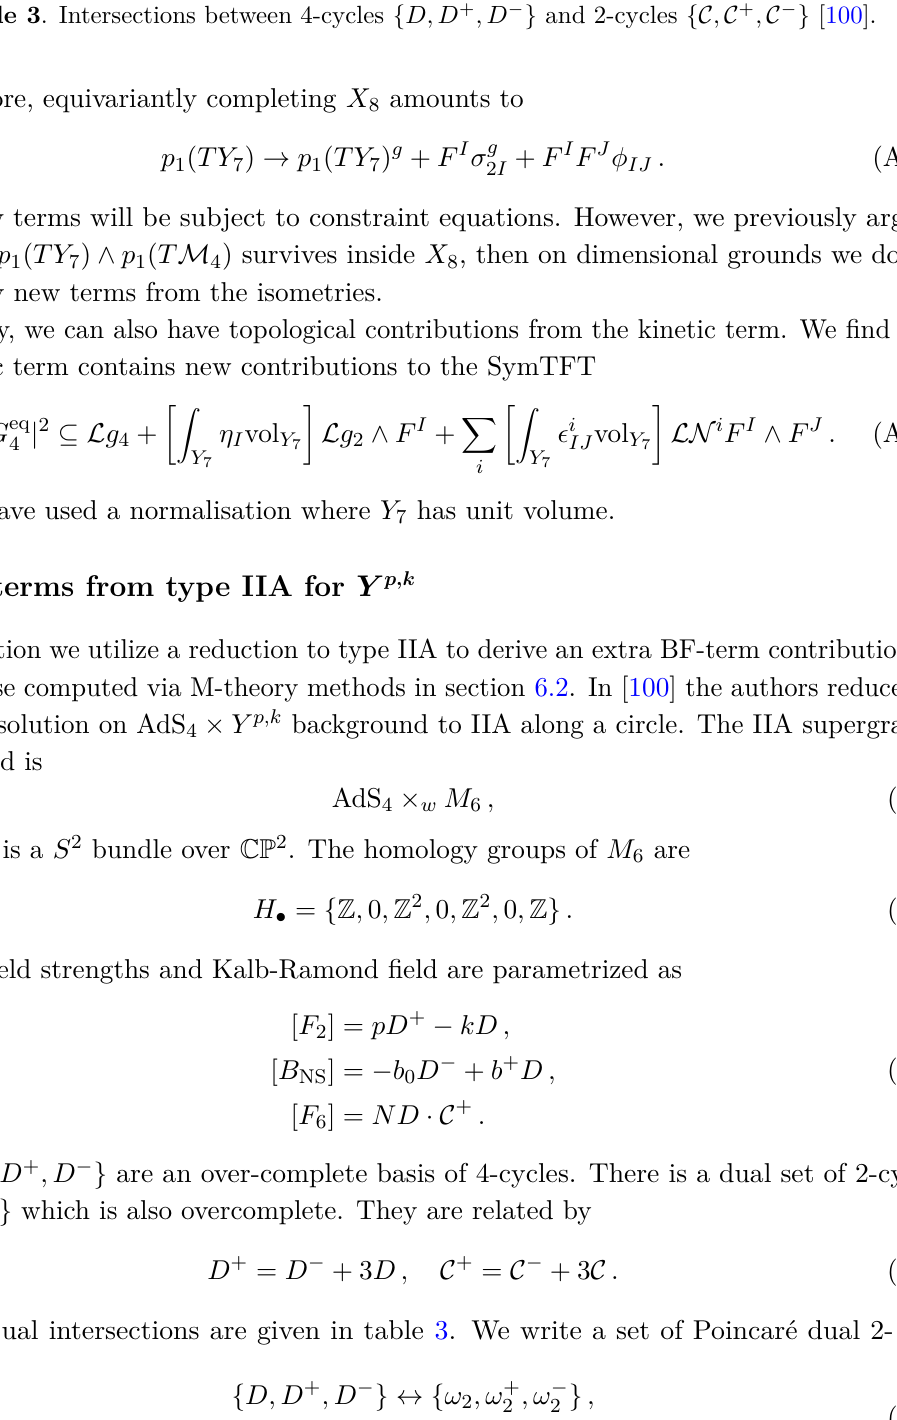
Table 3 . Intersections between 4-cycles { D, D + , D − } and 2-cycles {C , C + , C − }